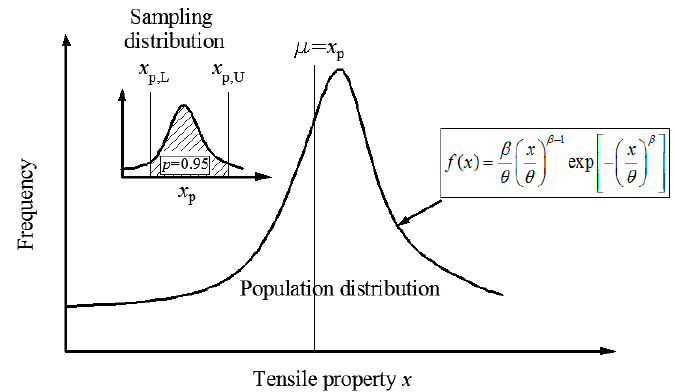
Figure 1. Illustration of the population distribution and the sampling distribution. Table 2. Two-side percentage points